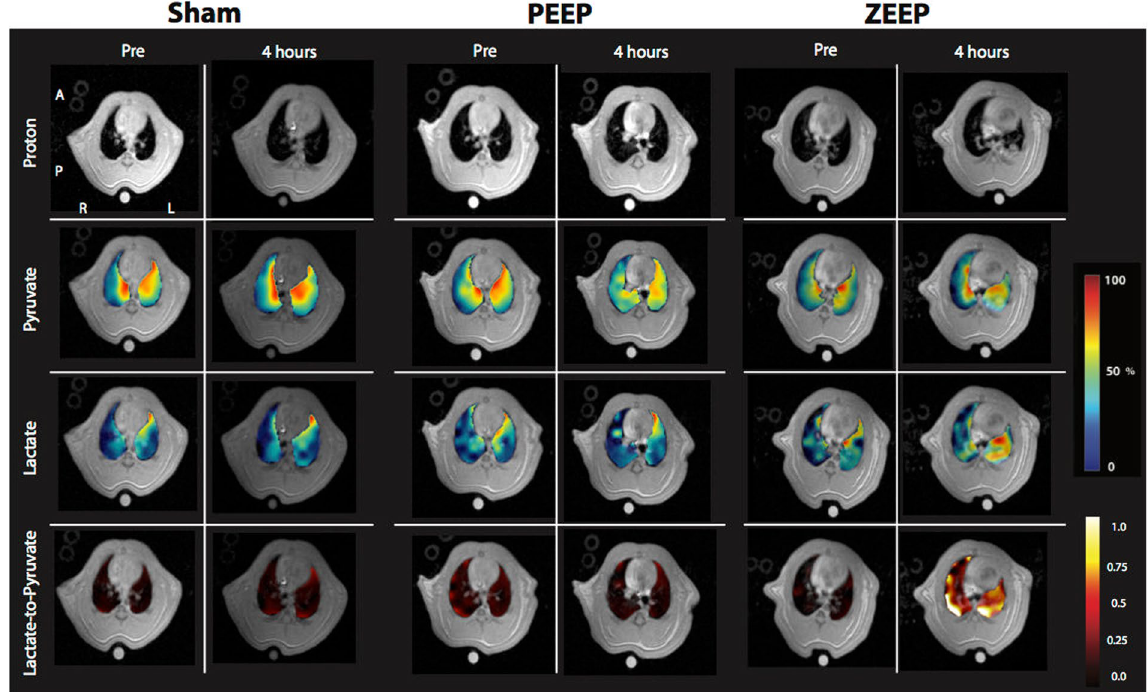
Figure 2. Representative proton images, pyruvate, lactate and lactate-to-pyruvate maps overlaid on their corresponding proton images. The left panels show the images acquired at healthy baseline and 4 hours after acid/saline instillation in a sham rat. The middle and right panels show similar maps for the PEEP and ZEEP rats. Note the dramatic increase in lactate signal and lactate-to-pyruvate ratio in the ZEEP rat 4 hours after acid instillation. The superimposed maps are segmented to show only the values within the lung fields. For display, the pyruvate and lactate maps are normalized to their own maximum intensity for each pulmonary map. Images acquired at the second and third time points are included in the supplementary